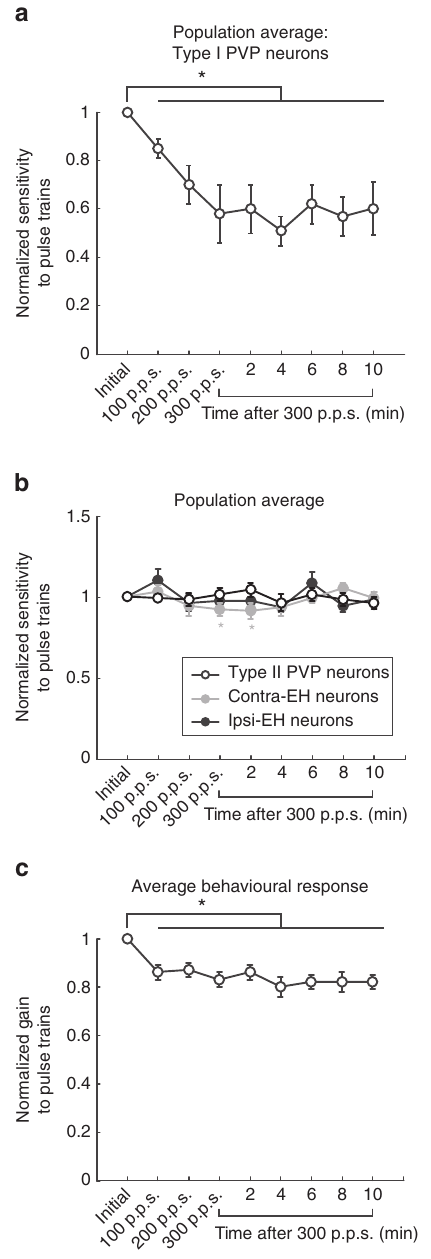
Figure 6 | Recovery of neuronal and behavioural responses following activation. ( a , b ) Normalized sensitivity of type I PVP neurons ( n ¼ 15) as well as type II PVP neurons ( n ¼ 10), contra EH cells ( n ¼ 14) and ipsi EH cells ( n ¼ 12) ( b ) over a 10-min period following activation of the vestibular nerve. ( c ) Normalized eye velocity gain over a 10-min period following activation of the vestibular nerve. Error bars represent ±